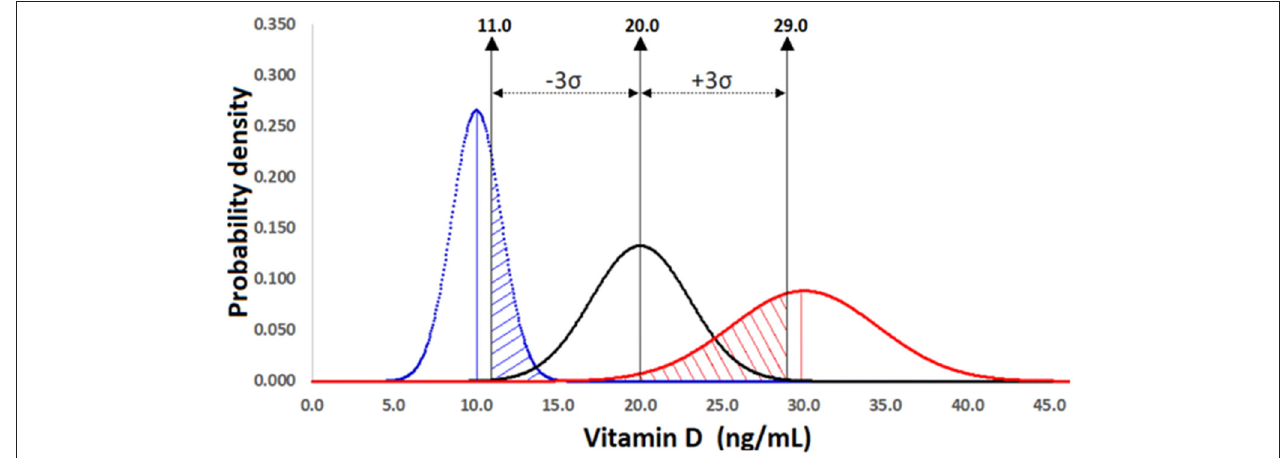
FIGURE 3 | Comparison of three normally distributed populations of athletes with 25(OH)D mean levels of 10ng/ml (insufficient, blue line curve), 20ng/ml (deficient, black line curve), and 30ng/ml (sufficient, red line curve) and the same coefficient of variation (CV = 15%). An overlapping of 0.25 (oblique blue and red lines) is observed between insufficient-deficient and sufficient-deficient within the range ± 3 σ of the deficient population, which causes a statistical power of 0.75 lower than the minimum desirable of 0.80. The mean values were obtained from a study on athletes published elsewhere